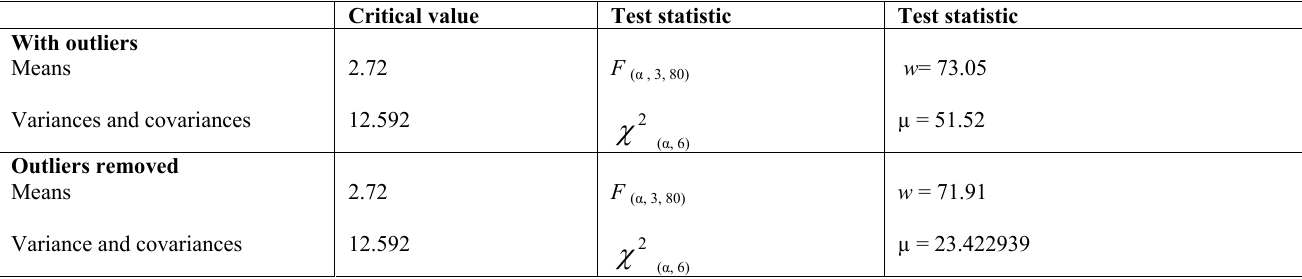
Table 2 . The results of the hypothesis tests for the variance-covariance matrices and means for Subject 1 are included. The level of significance is p = 0.05. The null hypothesis ( H ) of equality is rejected if the test statistic is o larger than the critical value. Critical value Test statistic Test